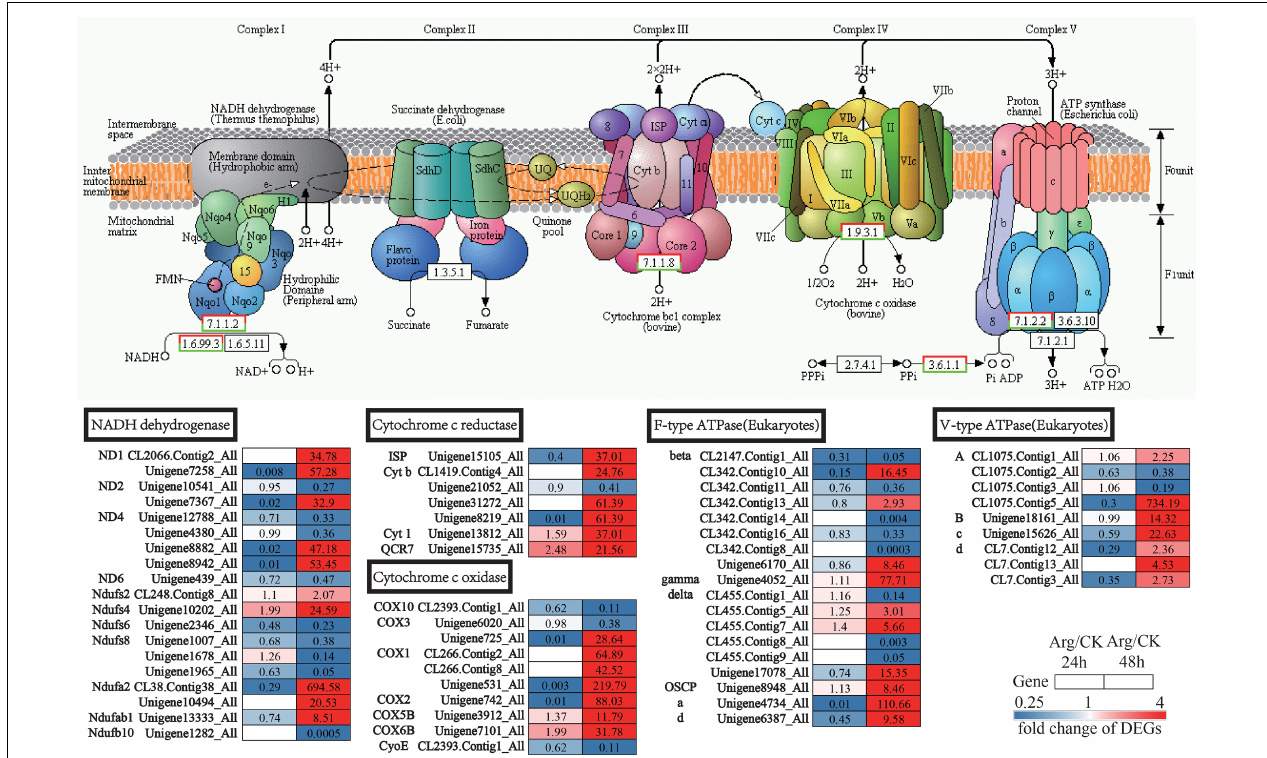
FIGURE 8 | The clustering chart of DEGs at oxidative phosphorylation on G. lemaneiformis . Color and number in each square indicate up- or downregulation and change level, respectively, white square means are not expressed at this time point. Note: the pattern diagram of oxidative phosphorylation is obtained from the KEGG website. DEGs, differentially expressed genes; KEGG, Kyoto Encyclopedia of Genes and